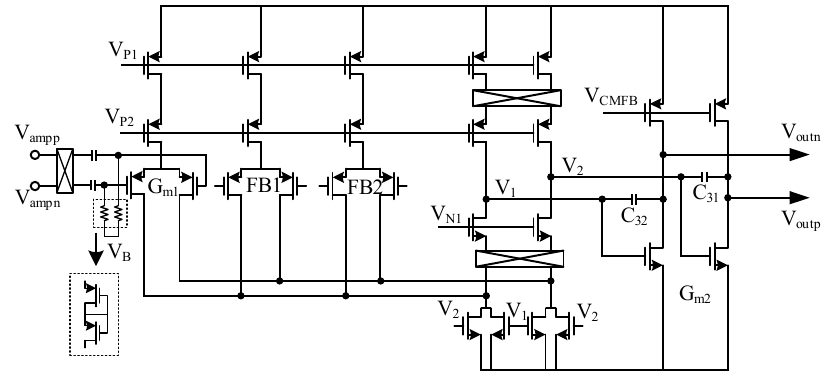
Figure 2. Circuit implementation of the chopper amplifier, gain control transconductance (FB 1 ) and ripple compensation transconductance (FB 2 ).